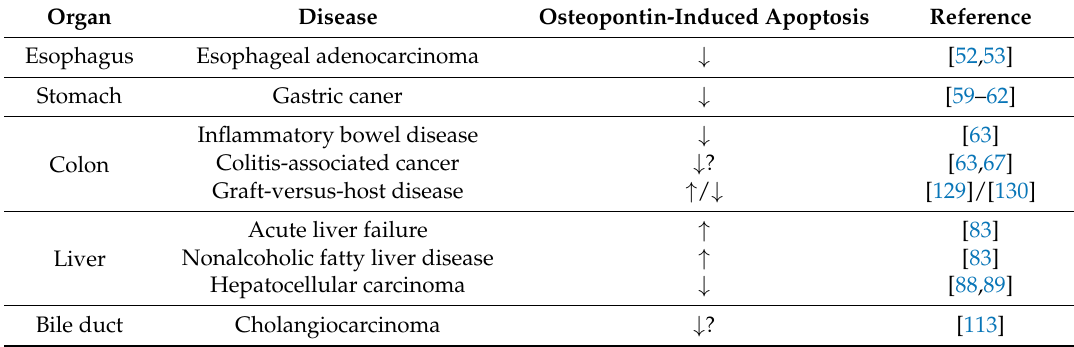
Table 1. Inflammatory gastrointestinal and liver diseases related to osteopontin-induced